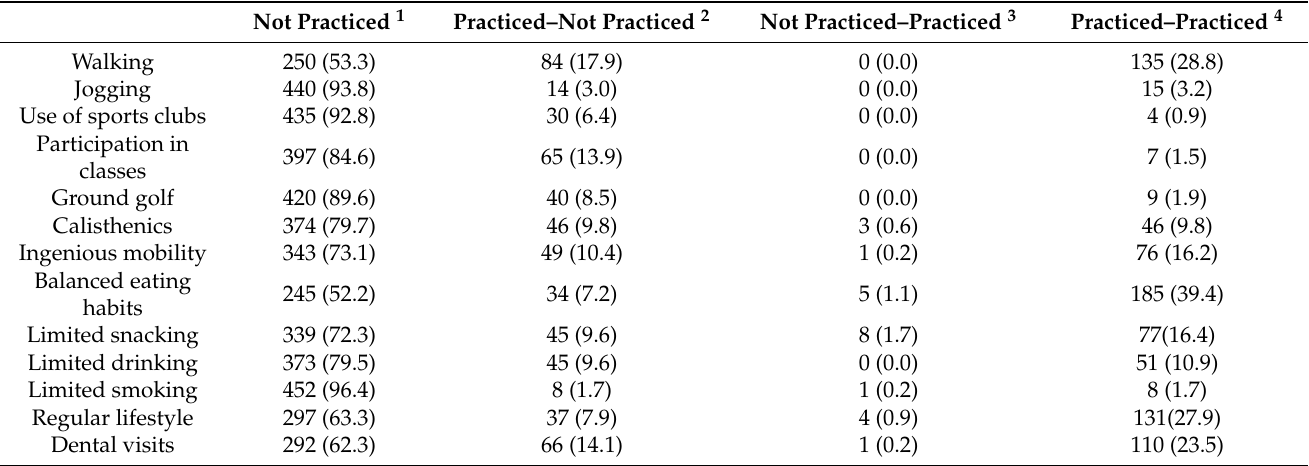
Table 3. Status of health behavior at the time of the survey (multiple